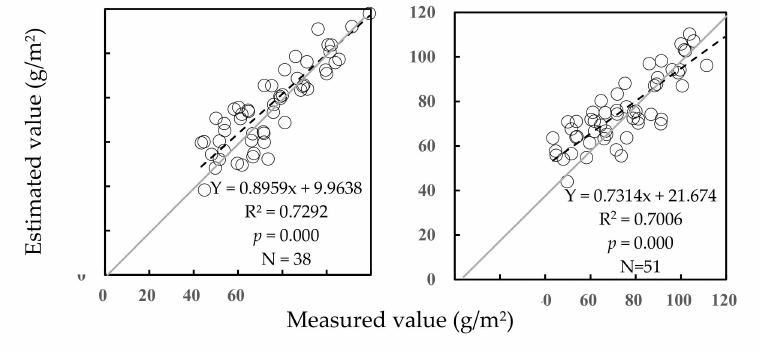
Figure 2. Validation of predictive equations for AGB of community under no grazing ( left ) and rotational grazing ( right